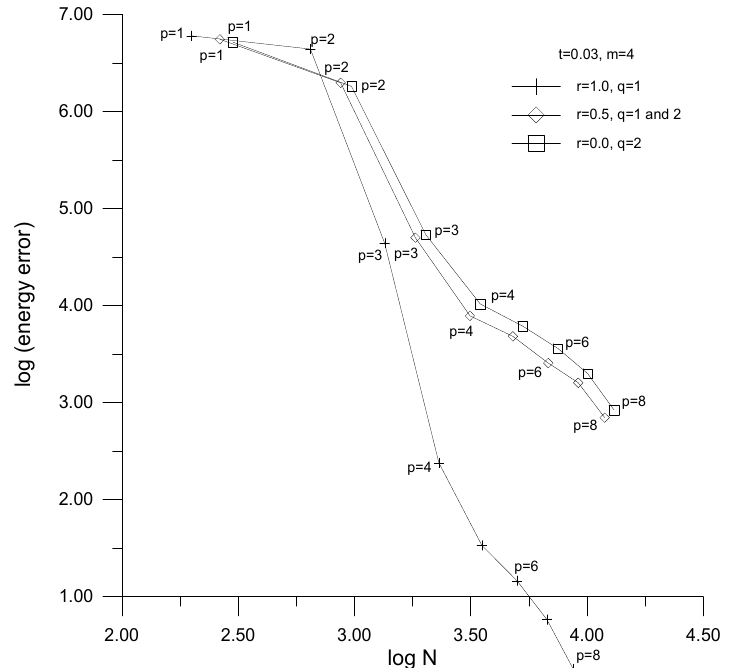
Figure 22. Convergence curves—the plate problem, the enhanced transition elements